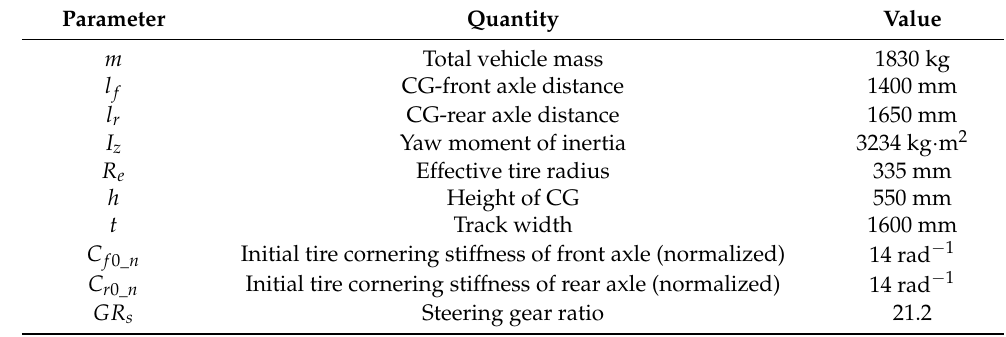
Table 1. Specifications of the simulation